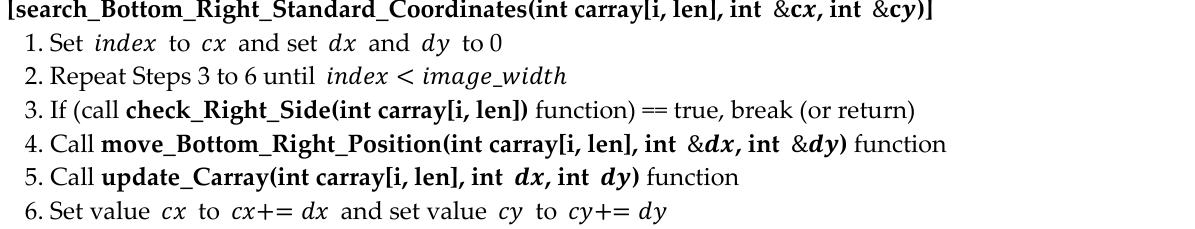
Figure 12. Proposed algorithm: reference point search for the lower-right corner.